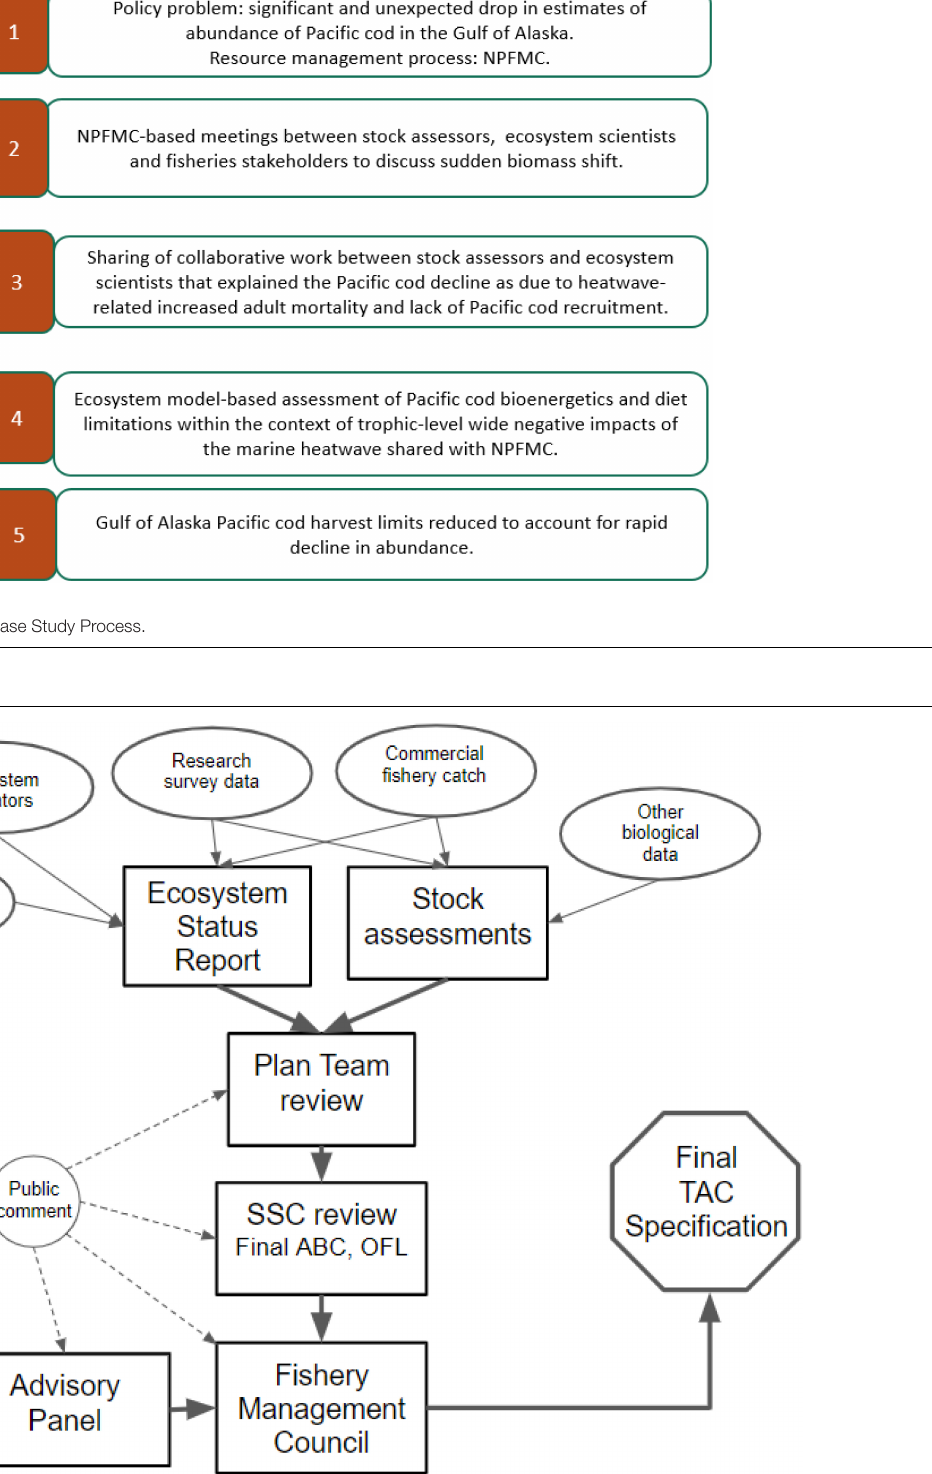
Frontiers in Marine Science |